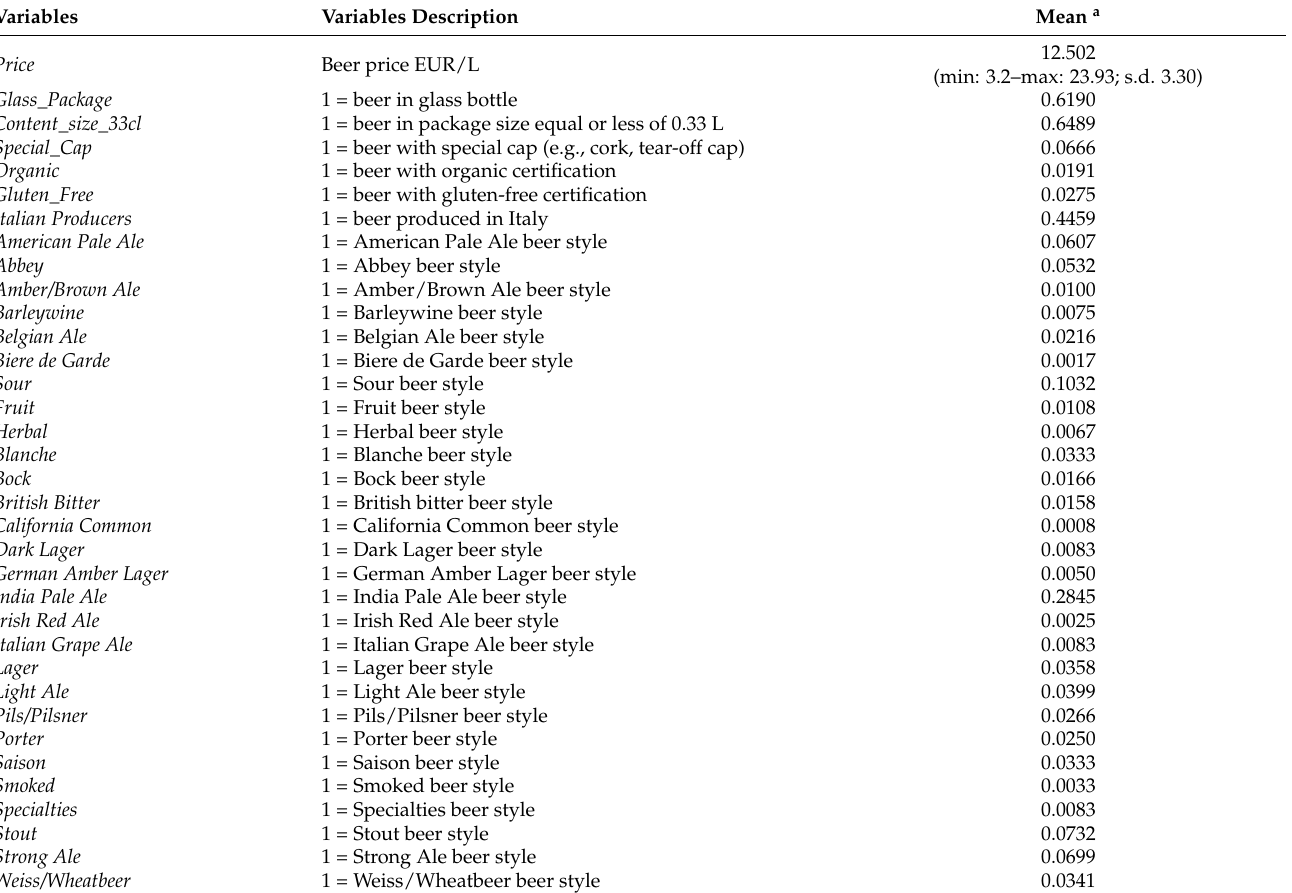
Table 2. Summary statistics and variables description (Obs. =